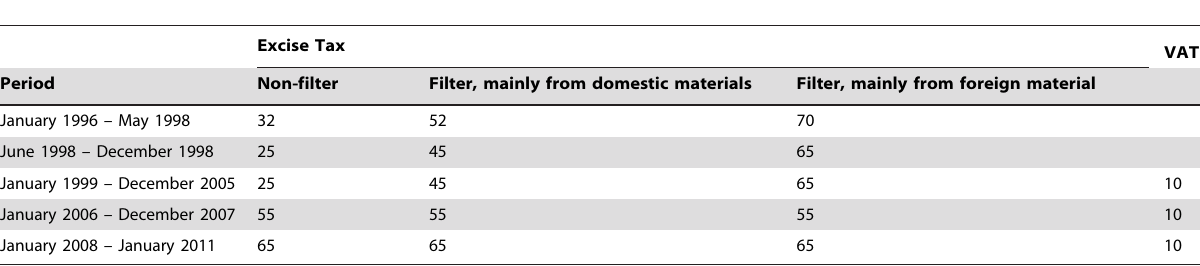
Table 1. Excise tax rates for cigarettes and tobacco products in Vietnam, 1996–2011